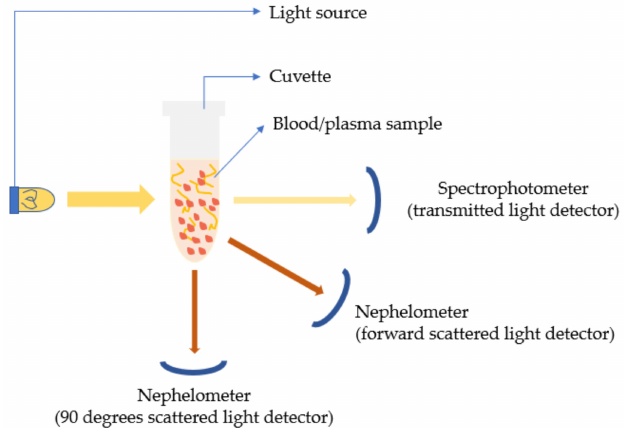
Figure 6. Schematic for conventional coagulation detection using optical methods (turbidimetry and